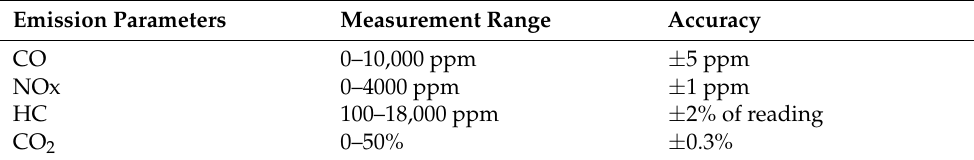
Table 4. Measurement Range and Accuracy of